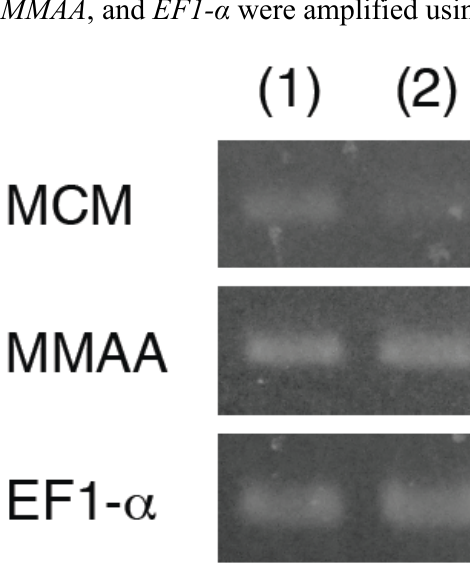
Figure 3. Semi-quantitative real-time (RT)-PCR analysis of the levels of MCM and MMAA transcripts in (1) Cbl-deficient and (2) Cbl-supplemented E. gracilis cultures. Fragments corresponding to MCM , MMAA , and EF1- α were amplified using